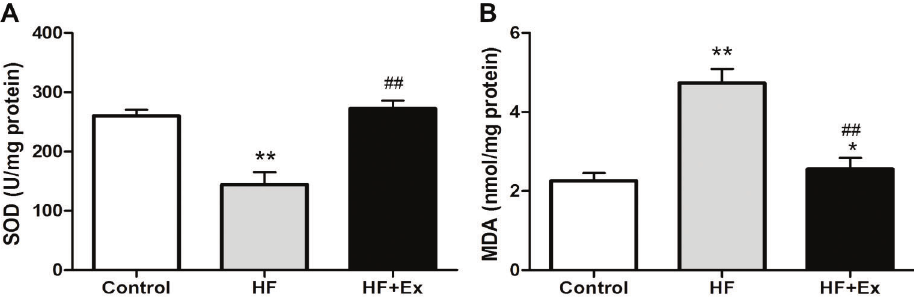
Figure 4. Effects of exenatide (Ex) on high fat (HF)-induced liver oxidative stress (n=8). After the 20-week study period, the contents of A , superoxide dismutase (SOD) and B , malondialdehyde (MDA) in livers from rabbits in each group were estimated. Data are reported as means ± SD. *P o 0.05, **P o 0.01 compared with the control group; ## P o 0.01 compared with the HF group (ANOVA).